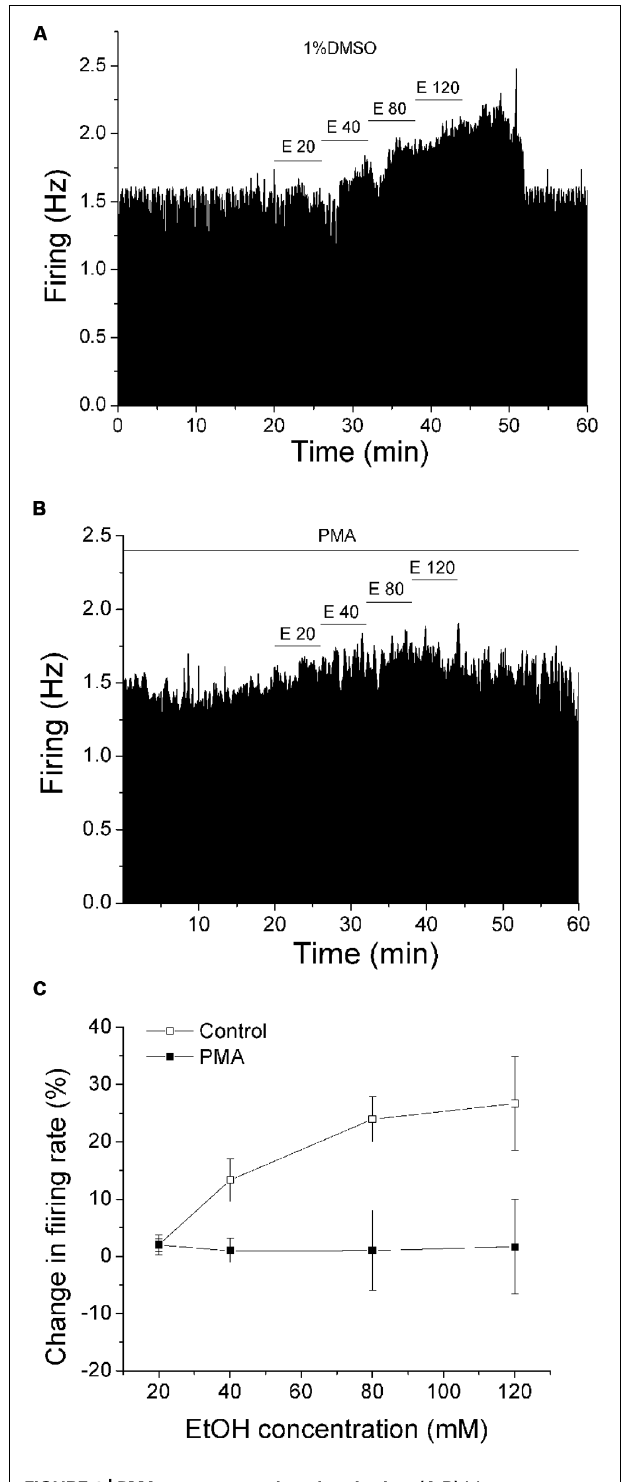
FIGURE 1 | PMA suppresses ethanol excitation. (A,B) Mean ratemeter graphs of the effects of ethanol application under different conditions on two different DAergicVTA neurons.Vertical bars indicate the firing rate over 5 s intervals. Horizontal bars indicate the duration of drug application (concentrations indicated above bar). Four doses of ethanol (20–120 mM)